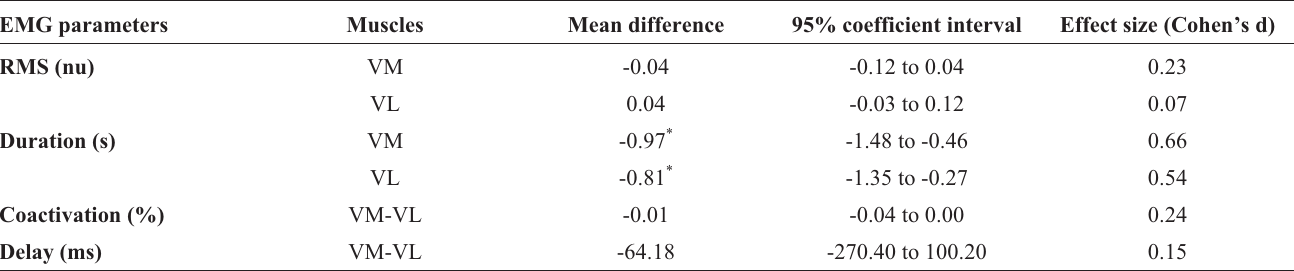
Table 3 - Data of mean difference, 95% coefficient interval and effect size of the EMG parameters in free squatting. EMG parameters Muscles Mean difference 95% coefficient interval Effect size (Cohen’s